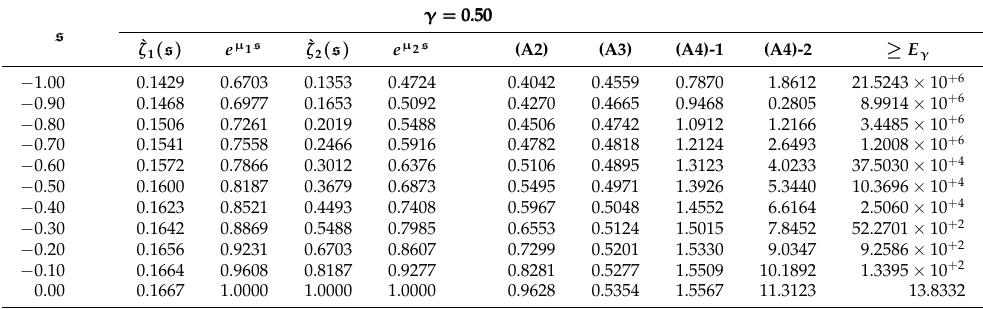
Table 3. Numerical results of (A1)–(A4) of the Gilpin–Ayala competition predator-prey system with harvesting terms (24) whenever γ = 0.13.